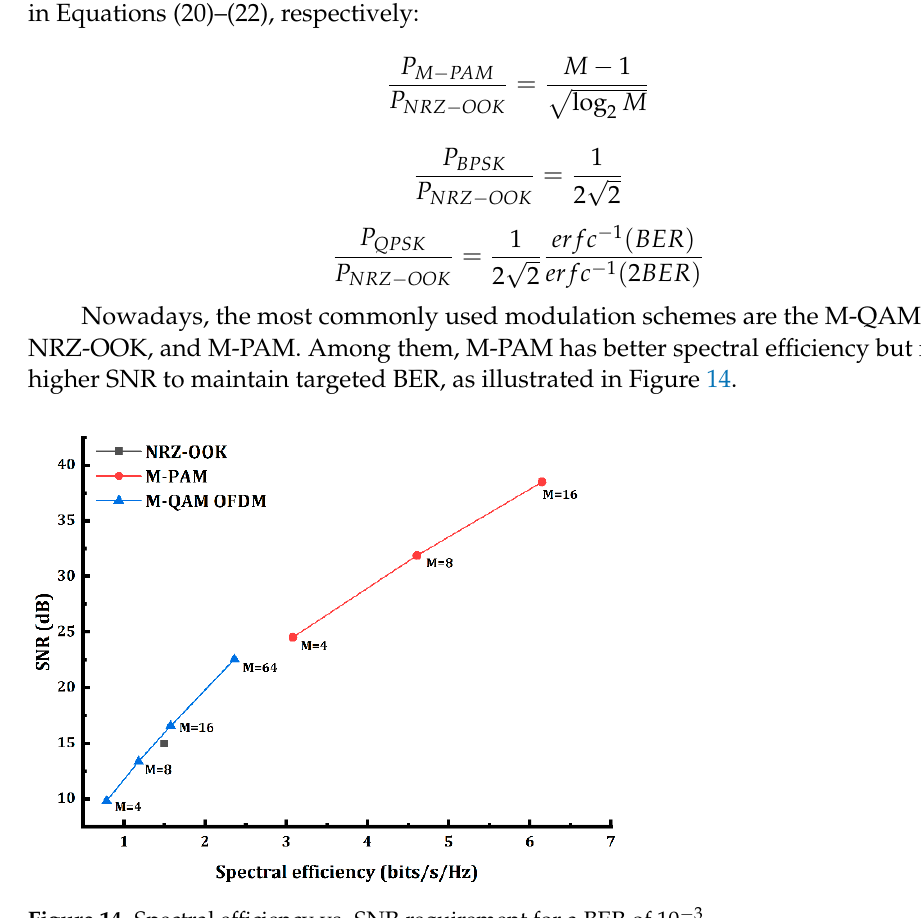
Figure 14. Spectral efficiency vs. SNR requirement for a BER of 10 − 3 .